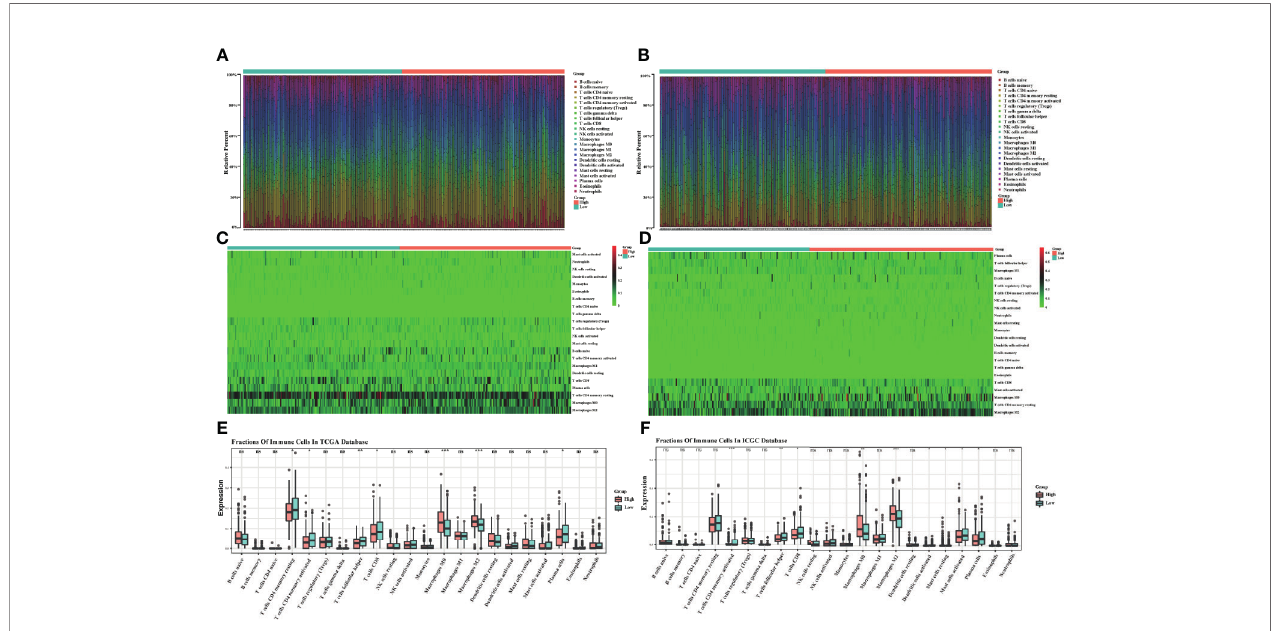
FIGURE 12 | The bar graphs for the distribution of 22 tumor-in fi ltrating immune cells between the high-risk and low-risk groups in the TCGA (A) and ICGC (B) datasets. The heatmaps for the correlation between risk groups and 22 immune cells in the TCGA (C) and ICGC (D) datasets. The boxplots for the comparison of the 22 immune cells between the high-risk and low-risk groups in the TCGA (E) and ICGC (F) datasets. *p < 0.05, **p < 0.01, ***p < 0.001. ns, no signi fi